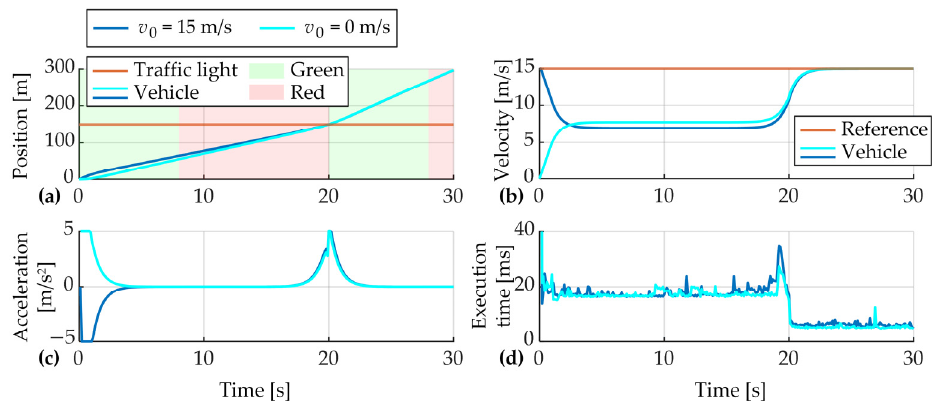
Figure 8. Comparative responses position ( a ), velocity ( b ), acceleration ( c ) and execution time ( d ) of linear MPC systems for initial vehicle velocities v 0 = 0 and v 0 = v R = 15 m/s.